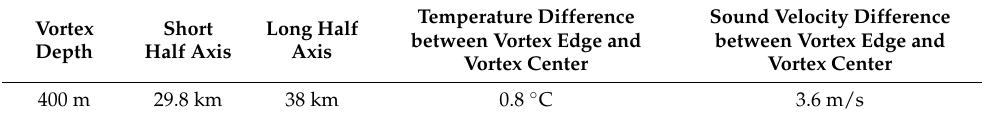
Table 3. Mesoscale vortex